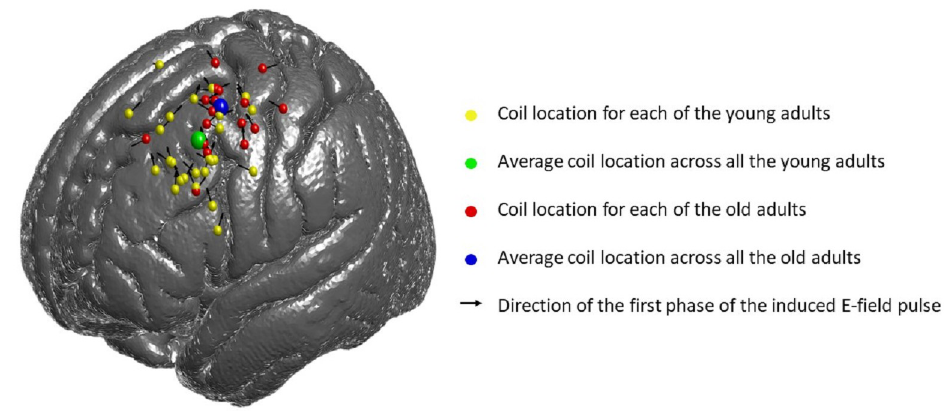
Fig 7. TMS coil position (spheres) and orientation (arrows) for each subject. The average coil location is displayed in yellow for the young, and in red for the older group. The spheres represent the coil location and the arrows correspond to the direction of the first phase of the induced E-field pulse (some of the arrowheads are not visible because of the 3D view). The green and the blue sphere represent the average coil location across all subjects, for the young and the old group,